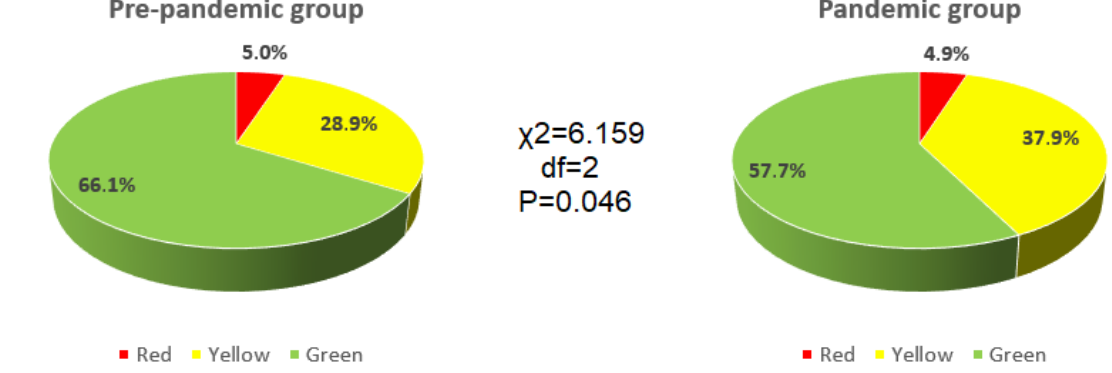
Figure 1. Code of access: pre-pandemic vs. pandemic group comparison.